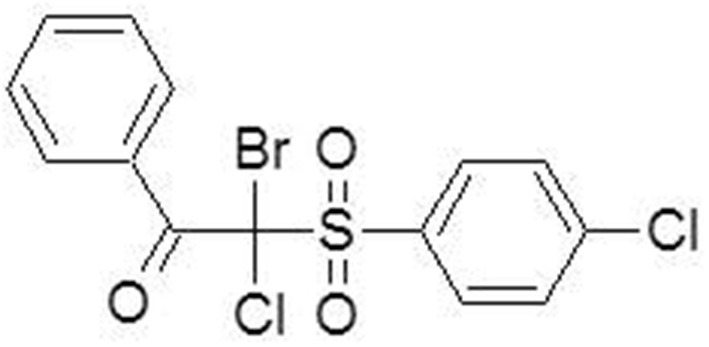
Chemical structure of β-ketosulfone (compound 4).